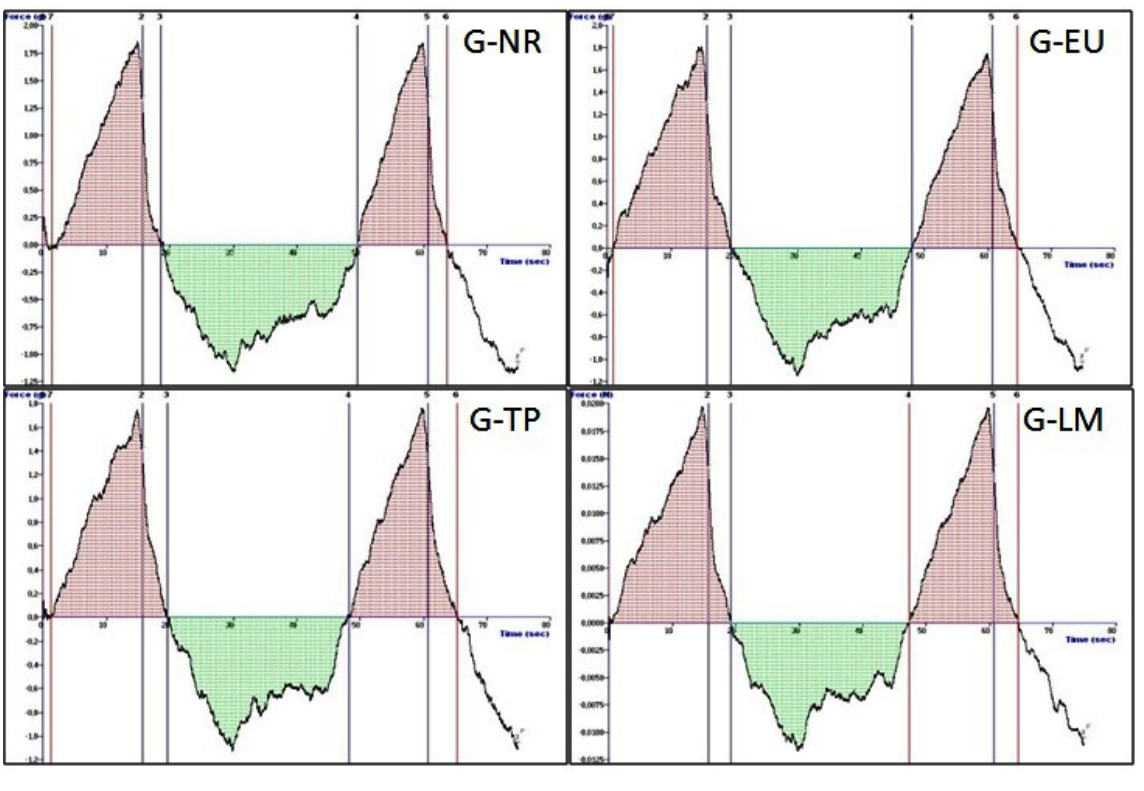
Figure 3. The force-time plots of sodium alginate based gel formulations G-NR, G-EU, G-TP, and